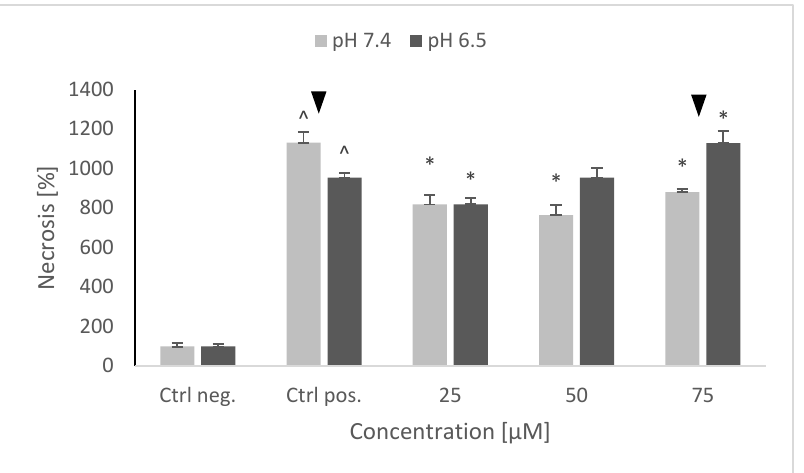
Figure 10. The level of necrosis after pretreatment of SH-SY5Y cells with NRNPs pH and exposure to 6-hydroxydopamine. The whiskers are standard deviation. ^ p ≤ 0.05, Student t -test vs. the negative control (Ctrl neg.; cells not treated with 6-OHDA), ▼ p ≤ 0.05, paired Student t -test, differences be- tween different pH conditions, * p ≤ 0.05, Student t -test vs. the positive control (Ctrl pos.; cells treated with 6-OHDA only, without any pretreatment); n = 3.